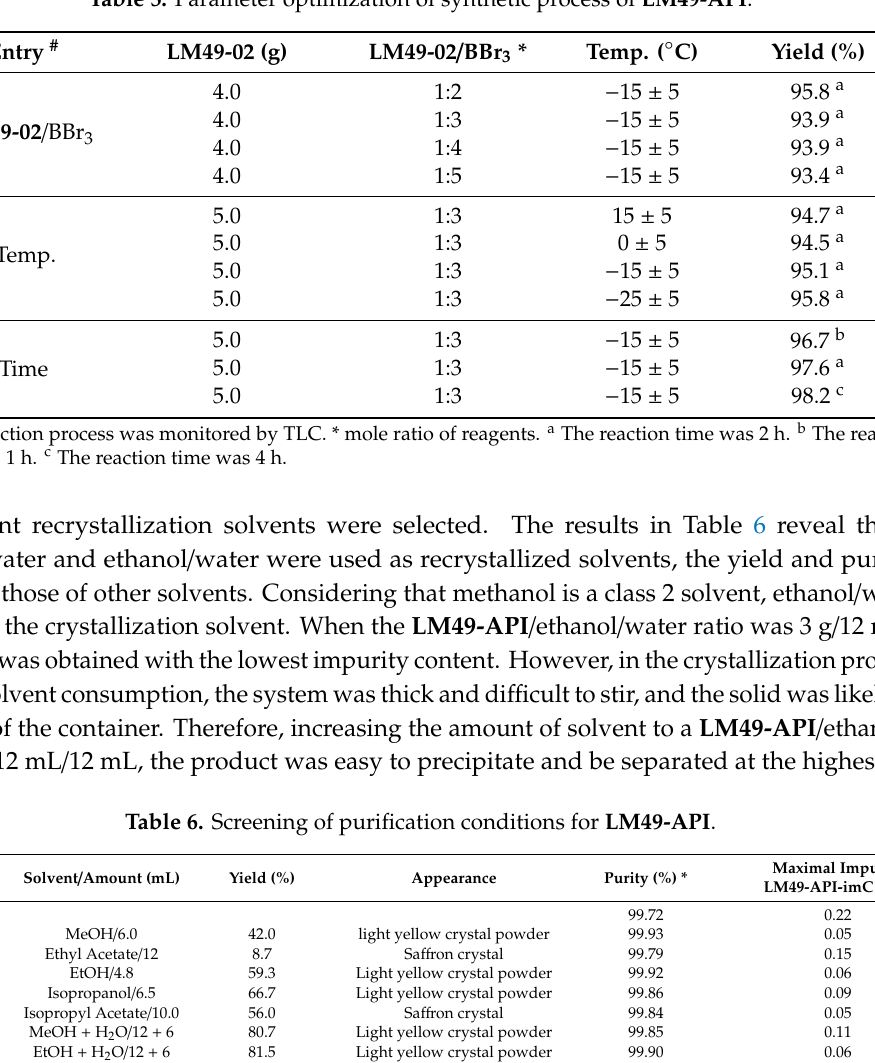
Table 5. Parameter optimization of synthetic process of LM49-API .